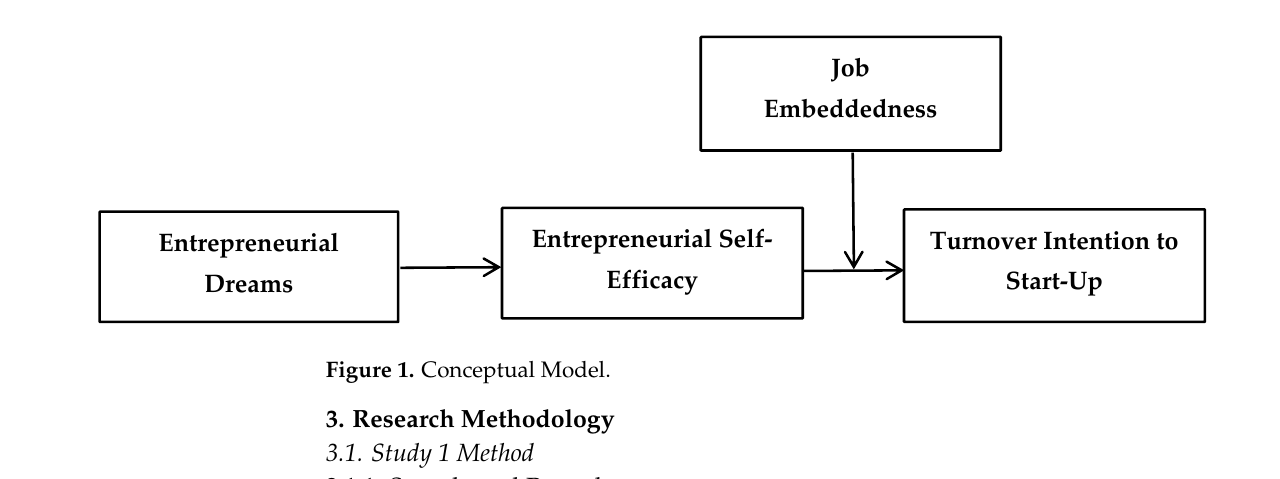
Figure 1. Conceptual Model.